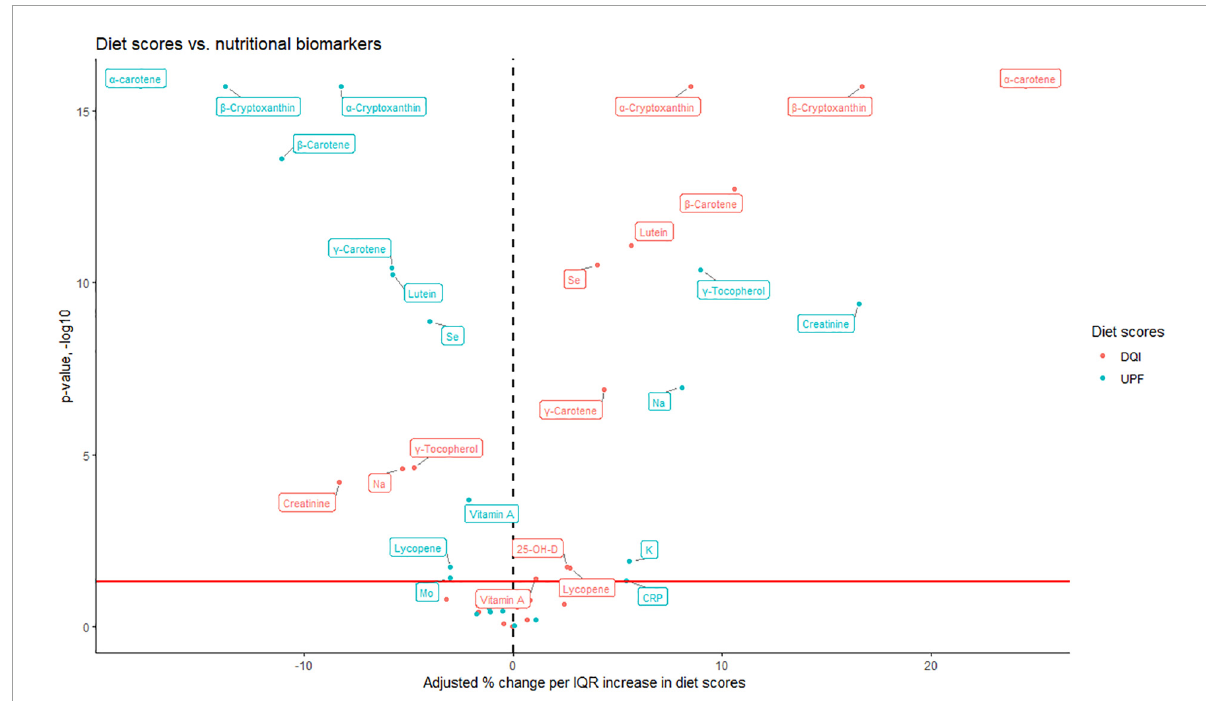
FIGURE2 Adjusted relative (%) change in biomarker concentration according to an interquartile range (IQR, 25th–75th percentile) increase in diet scores (DQI and UPF), estimated by linear regression. Red horizontal line is indicating the –log10 transformed value corresponding to p -value = 0.05, and an increasing value on the y -axis corresponds to a decrease in the p -value. Only biomarkers with p -value < 0.05 are indicated with a text box. Adjusted for age at delivery, parity, pre-pregnancy BMI, education level, alcohol intake, and smoking status. CRP, C-reactive protein; DQI, diet quality index; UPF, ultra-processed food; 25-OH-D, 25-hydroxyvitamin